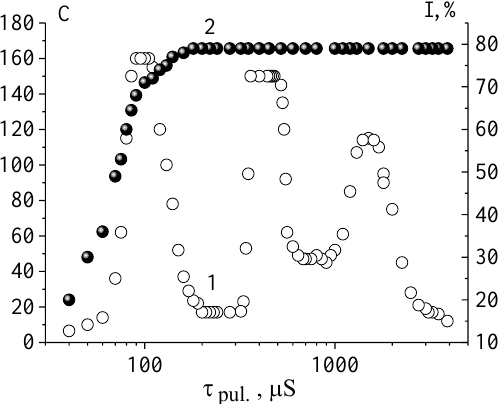
Figure 14. Dependences of light scattering C (curve 1) and light transmission I without scattering (curve 2) on the duration of bipolar voltage pulses with a fixed amplitude (±50 V). The thickness of an FLC cell with the HF-32 composition is 18 μm.